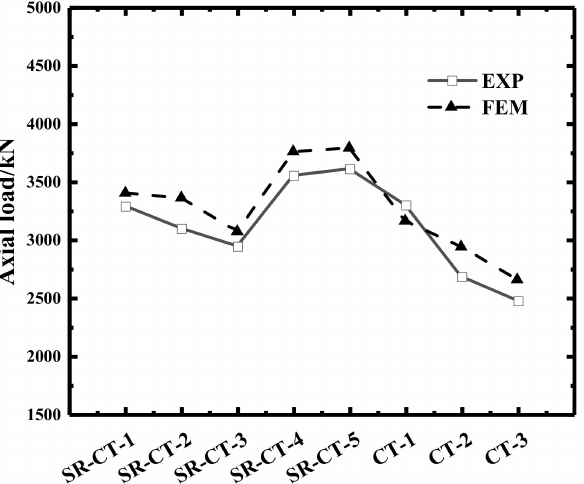
Figure 10. Comparison of ultimate bearing capacities from experiments and